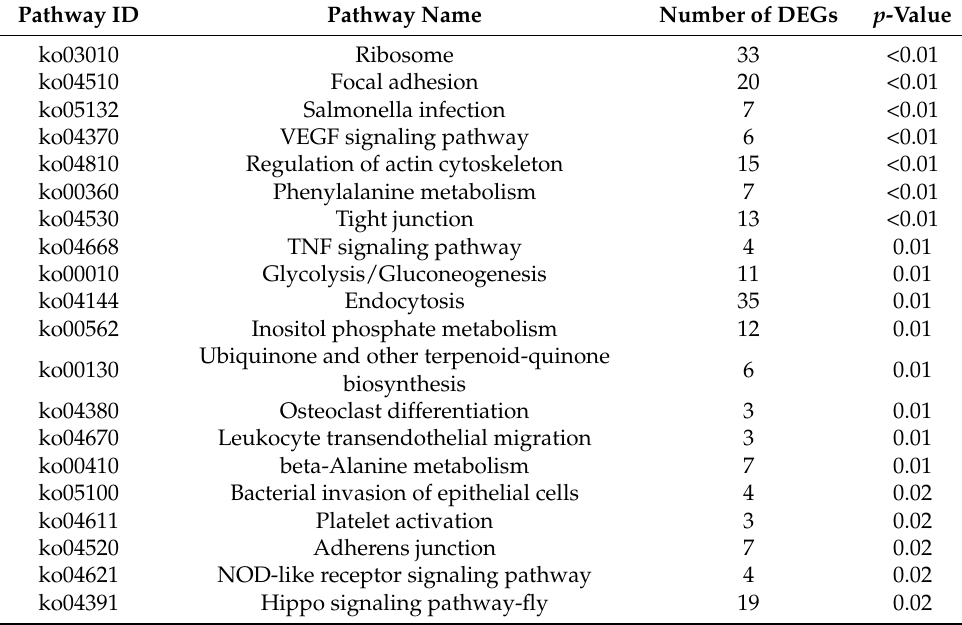
Table 2. The main enriched KEGG pathways ( p < 0.05) in the H2S-treated and the control groups.